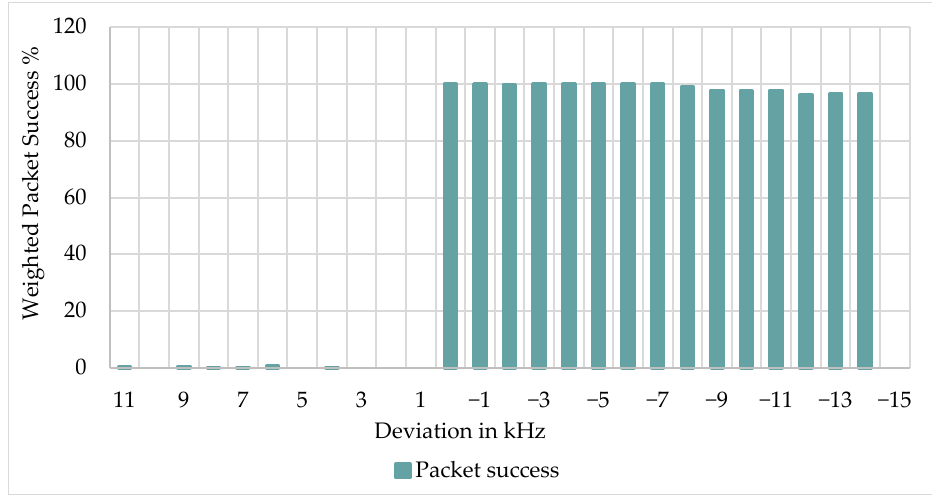
Figure 20. Weighted packet success rate for frequency deviation in steps of 1 kHz.